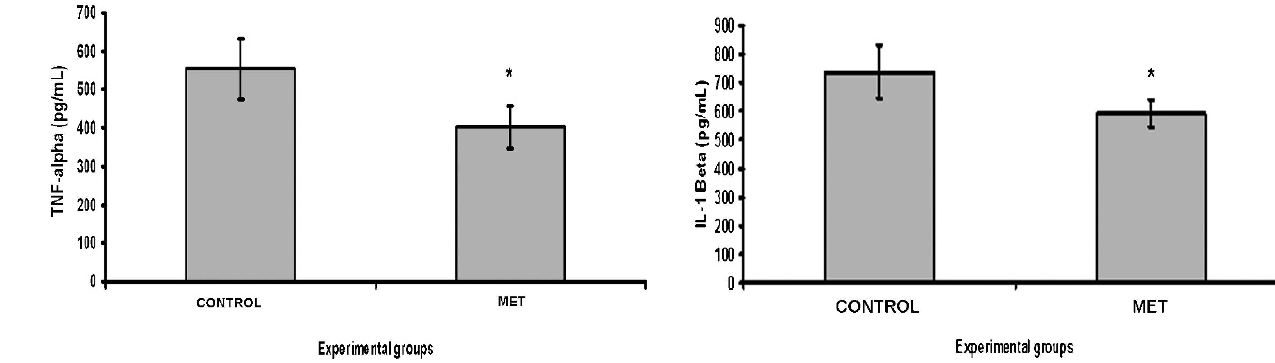
Figure 2 - Pulmonary interleukin-1 beta assay. After transplanta- tion, there was a significant decrease in the levels of interleukin- 1 beta in the methylprednisolone group compared with the control group (*p=0.0155). The values are expressed as the mean ¡ standard error of the